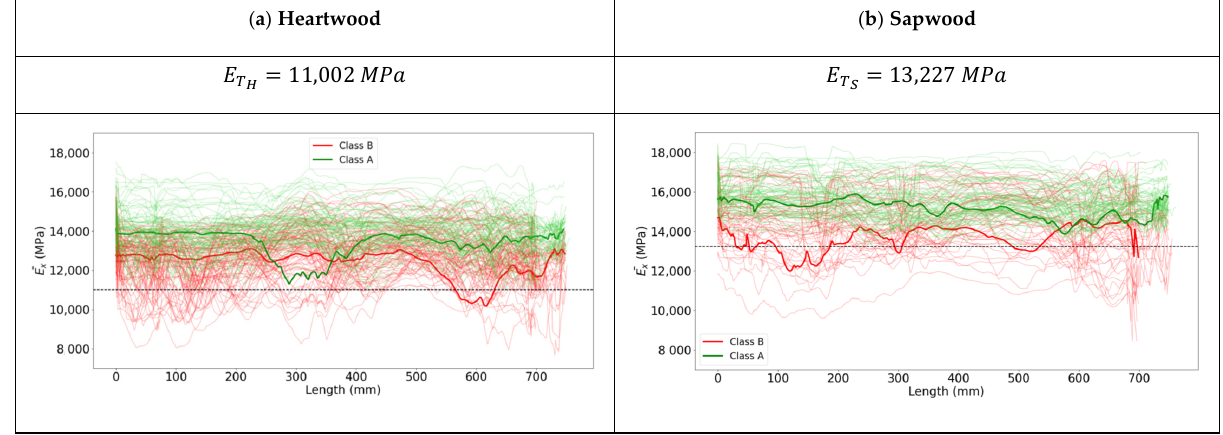
Figure 8. Veneer sorting by stiffness profile according to several methods (12% MC): ( a ) heartwood, ( b ) sapwood.